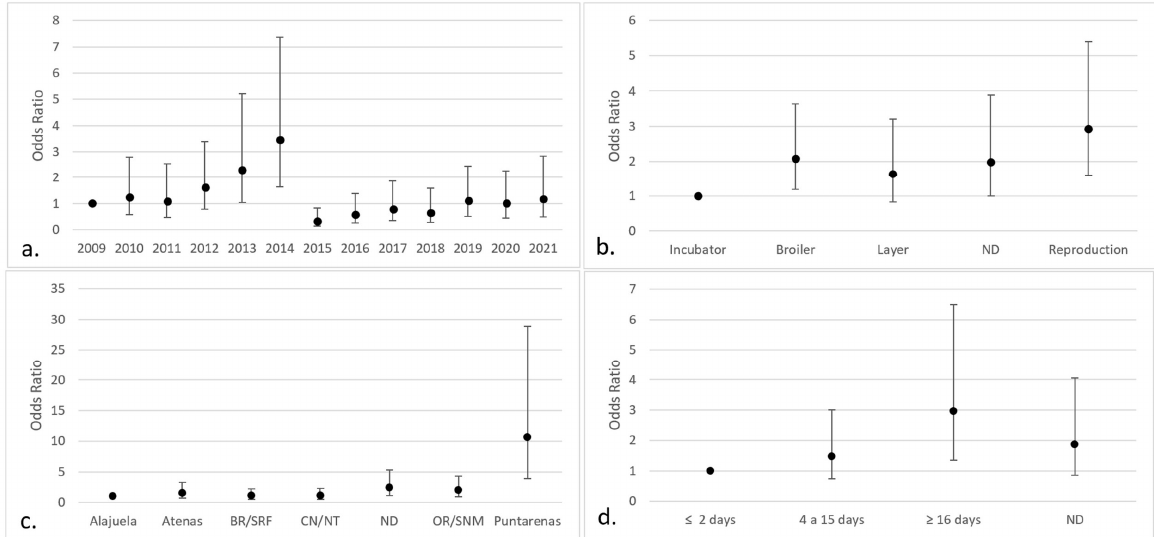
Figure 3. Categories with the highest risk of positive fungal isolates in chicken lungs ( Gallus gallus ) from 2008 to 2021 in the Mycology Laboratory, School of Veterinary Medicine, Universidad Nacional, Heredia, Costa Rica. ( a ) Year of remission; ( b ) productive purpose of the bird; ( c ) location (county) of origin; ( d ) bird age. 2009 includes 2008; ND = non determinate productive purpose; BR/SRF = Barva and San Rafael; CN/NT = counties from the center and north of Alajuela; ND = non-determinate origin and Dota, Santa Ana, Sarapiquí, Turrialba, Turrubares, Upala, Río Cuarto, San Carlos, and Pavas; OR/SNM = Orotina and San Mateo; ND = non-determinate age of the birds. Regarding the breed significant differences, they were noted in “others” (OR 3.14; IC 95% 1.31–7.56) and for poultry in which the breed was not specified (OR 1.79; IC 95% 1.06– 3.02) (Figure 4).